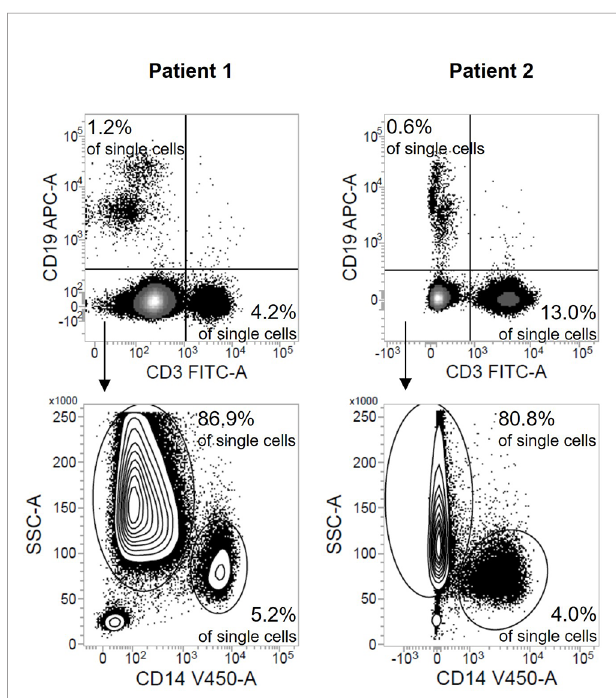
FIGURE 3 | Depletion of CD15 + cells leads to a small loss of PBMC. Flow cytometric results after staining of the fraction containing the depleted CD15 + cells shown as density plots (sepsis: n = 2). Numbers indicate the proportion of B cells, T cells, monocytes, and low-density granulocytes respectively in all single